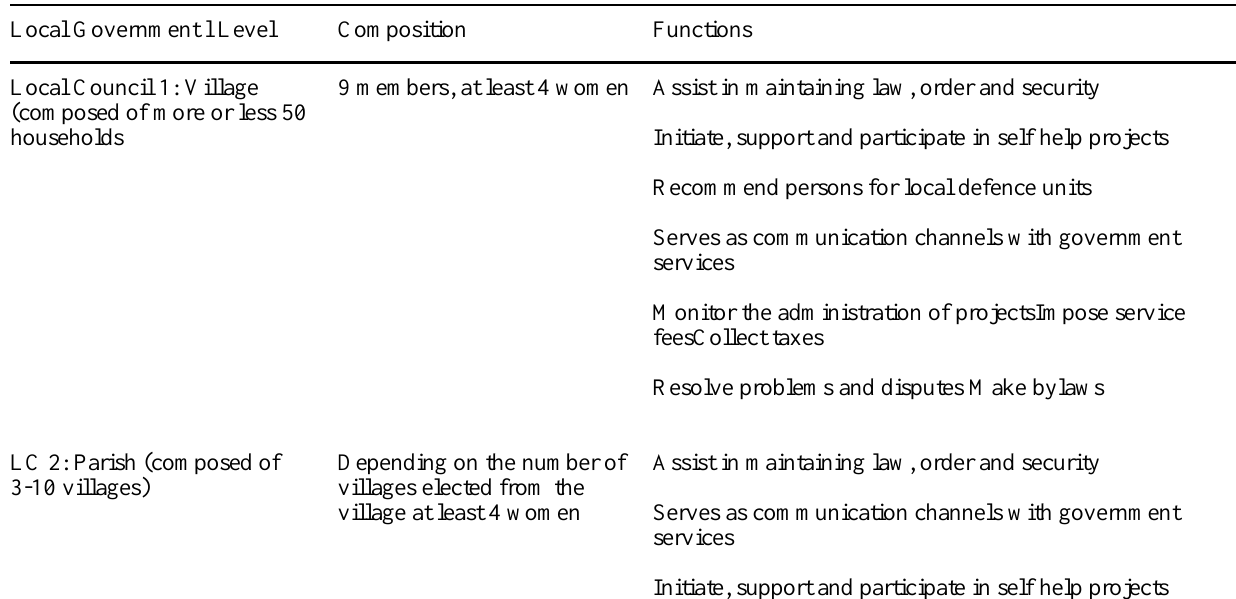
Table 1. Levels and main functions of decentralised local government structures in